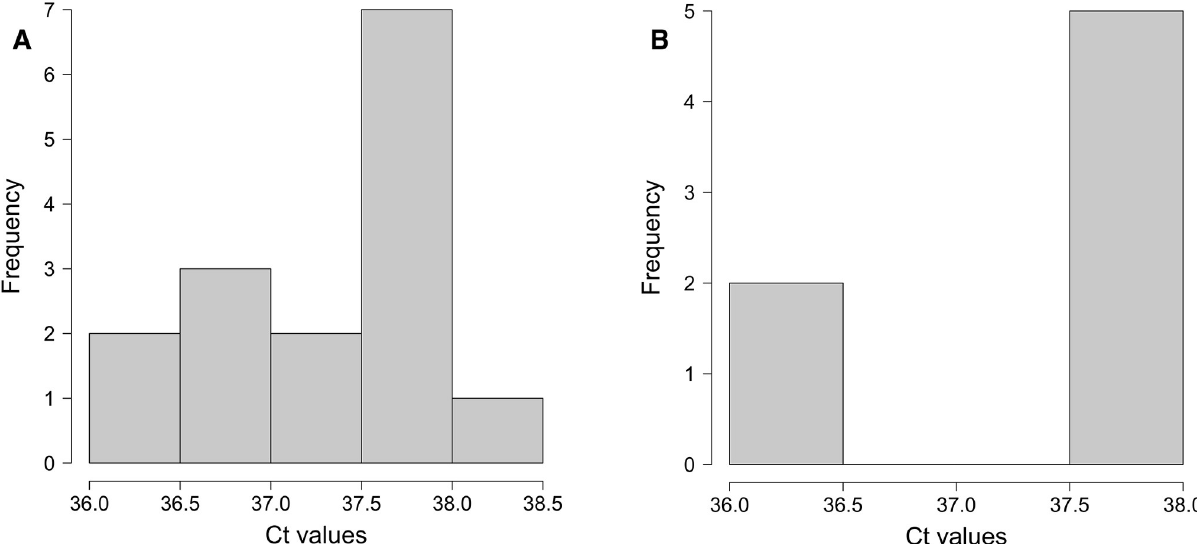
Fig 3. Frequency distributions of cycle threshold (Ct) values for positive samples from ( A ) HEPA filters and ( B ) floors at Schools A, B, C, and D. All positive samples were processed using the MagMAX automated extraction protocol and tested using a SARS-CoV-2 S gene RT-qPCR assay.